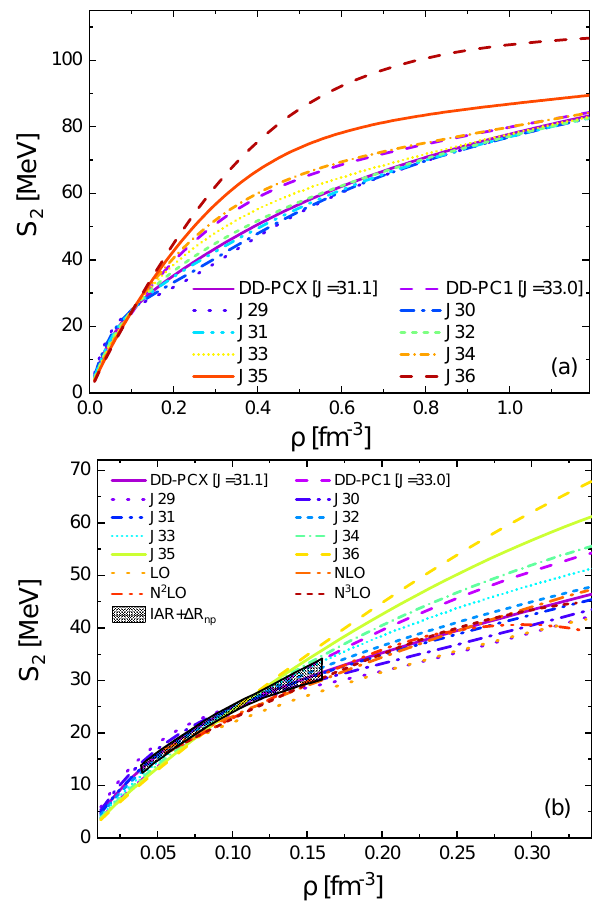
Figure 2. ( a ) Symmetry energy as a function of density using a family of point-coupling functionals with J = 29, 30, ..., 36 MeV alongside the DD-PC1 and DD-PCX functionals. For the DD-PCX and DD-PC1 functionals, the symmetry energy values around the saturation densities are given within the square brackets in units of MeV. ( b ) The same but for densities up to 0.34 fm − 3 , with the results of the chiral effective field theory ( χ EFT) (see Reference [51]). The isobaric analog state (IAS) and neutron skin ( ∆ R np ) constraints on the symmetry energy (see Reference [22] for more details) are also